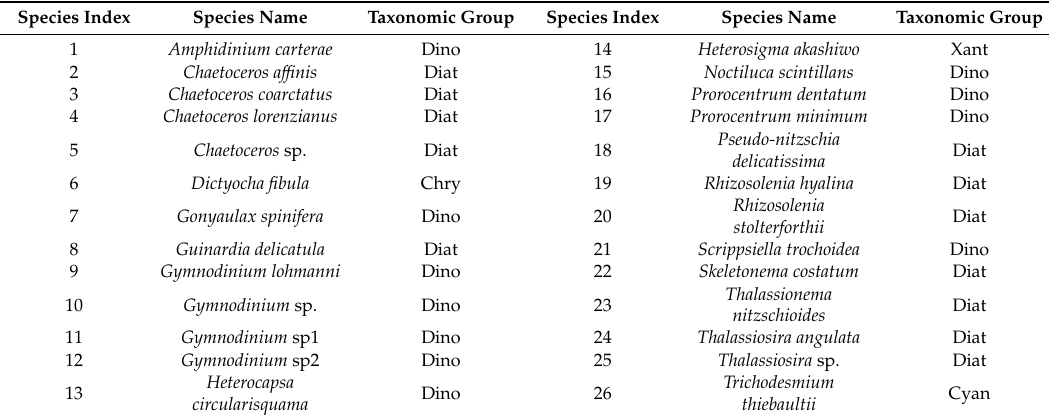
Table 1. The 26 most abundant phytoplankton species acquired in the validation dataset used in this